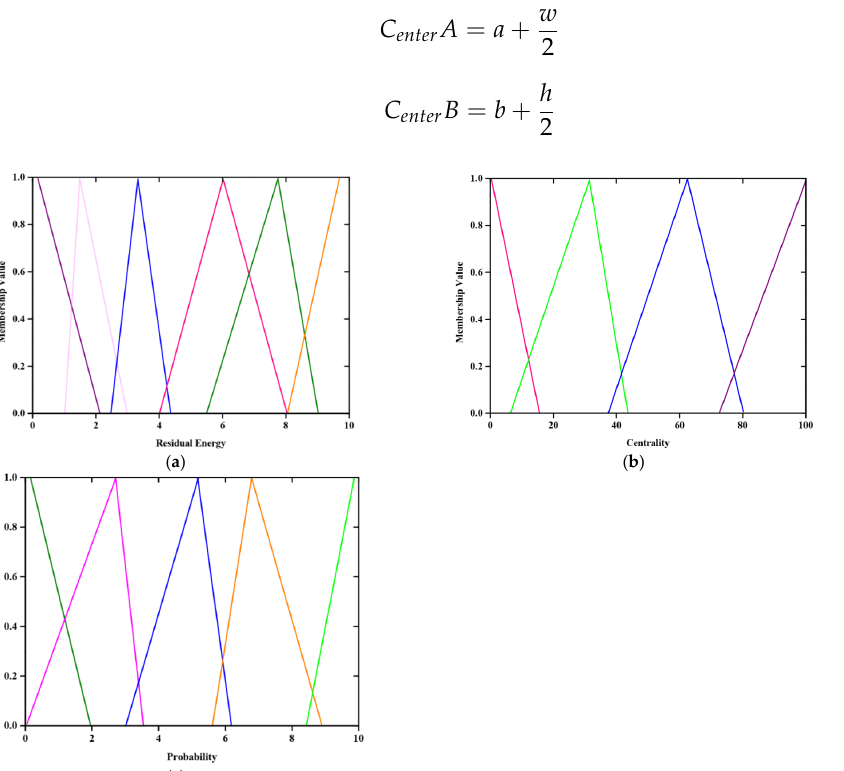
Figure 3. ( a ) fuzzy set for residual energy, ( b ) fuzzy set for centrality and ( c ) fuzzy set for provabil- ity of CH selection. of CH